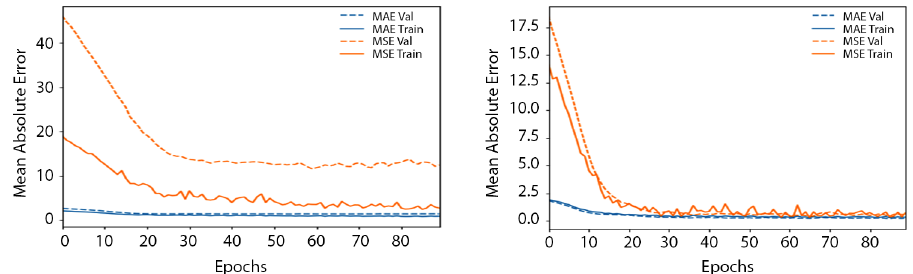
Figure 6. Experiment E3. Regression with observations from one year (average MAE = 0.87/1.37, MSE = 2.71/12) E3a) left; observations from two years (average MAE = 0.27/0.18, MSE = 0.34/0.41) – E3b)